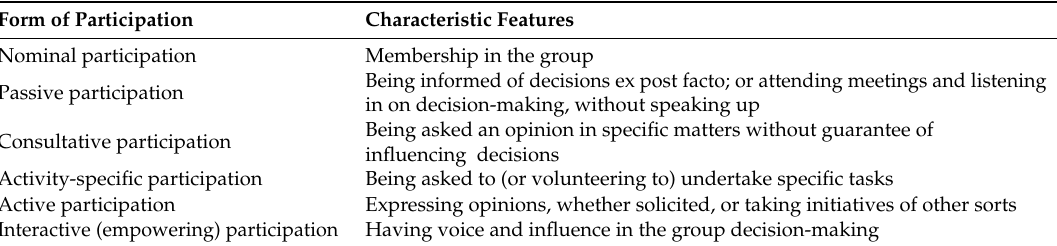
Table 1. Agrawal’s typology of